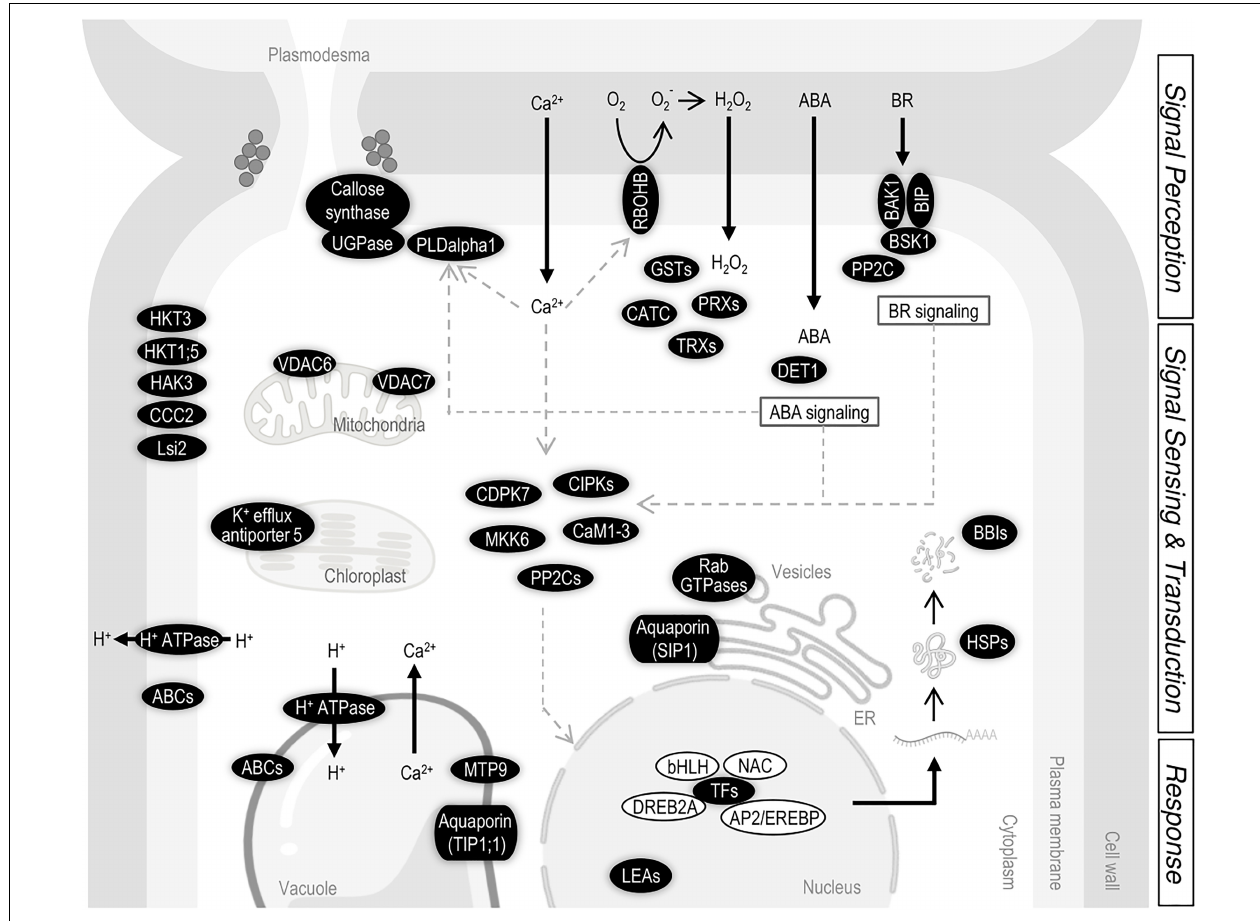
FIGURE 8 | Summary of the salt-related genes located in the indica introgressed regions of IL22. Thick black arrows indicate entrance or exit of molecules. Thin black arrows indicate steps in a process or chemical reaction. Gray arrows indicate interactions or regulations between components. ABC ( ATP Binding Cassette transporters ), AP2/EREBP ( APETALA2/ethylene-responsive element binding protein TF), BAK1 ( Brassinosteroid Insensitive 1 (BRI1)-associated receptor kinase1), BBI ( Bowman–Birk proteinase Inhibitor ), bHLH ( Basic helix–loop–helix TF), BIP [ Brassinosteroid receptor kinase (BRI1)-interacting protein ], BSK1 (